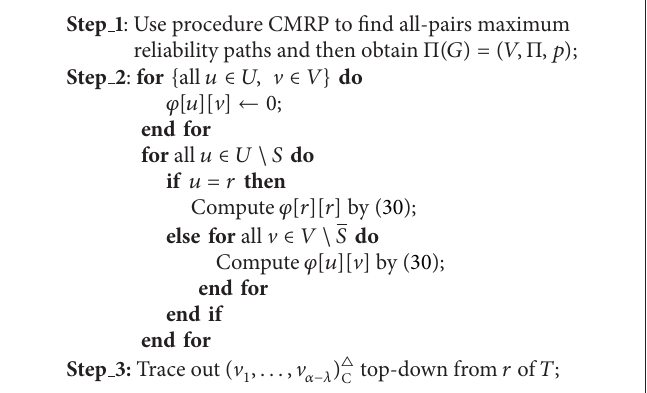
Algorithm 5: ( V 1 ,..., V 𝛼−𝜆 ) △